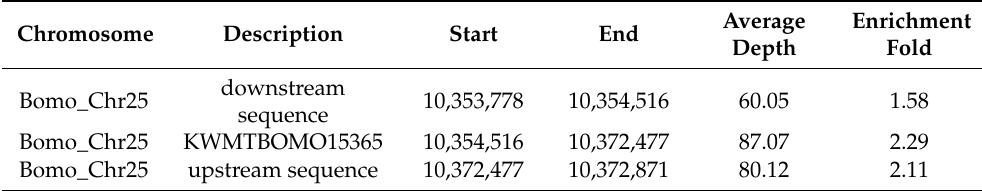
Table 2. Enrichment efficiency of the target